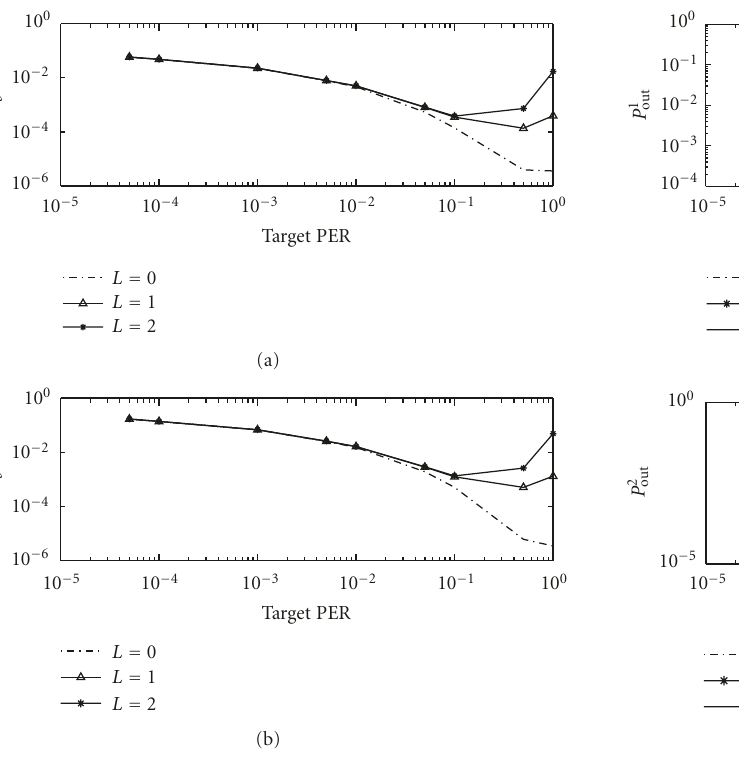
Figure 8: GMDP-based AC polices: blocking probability as a func- tion of target PER in which ρ